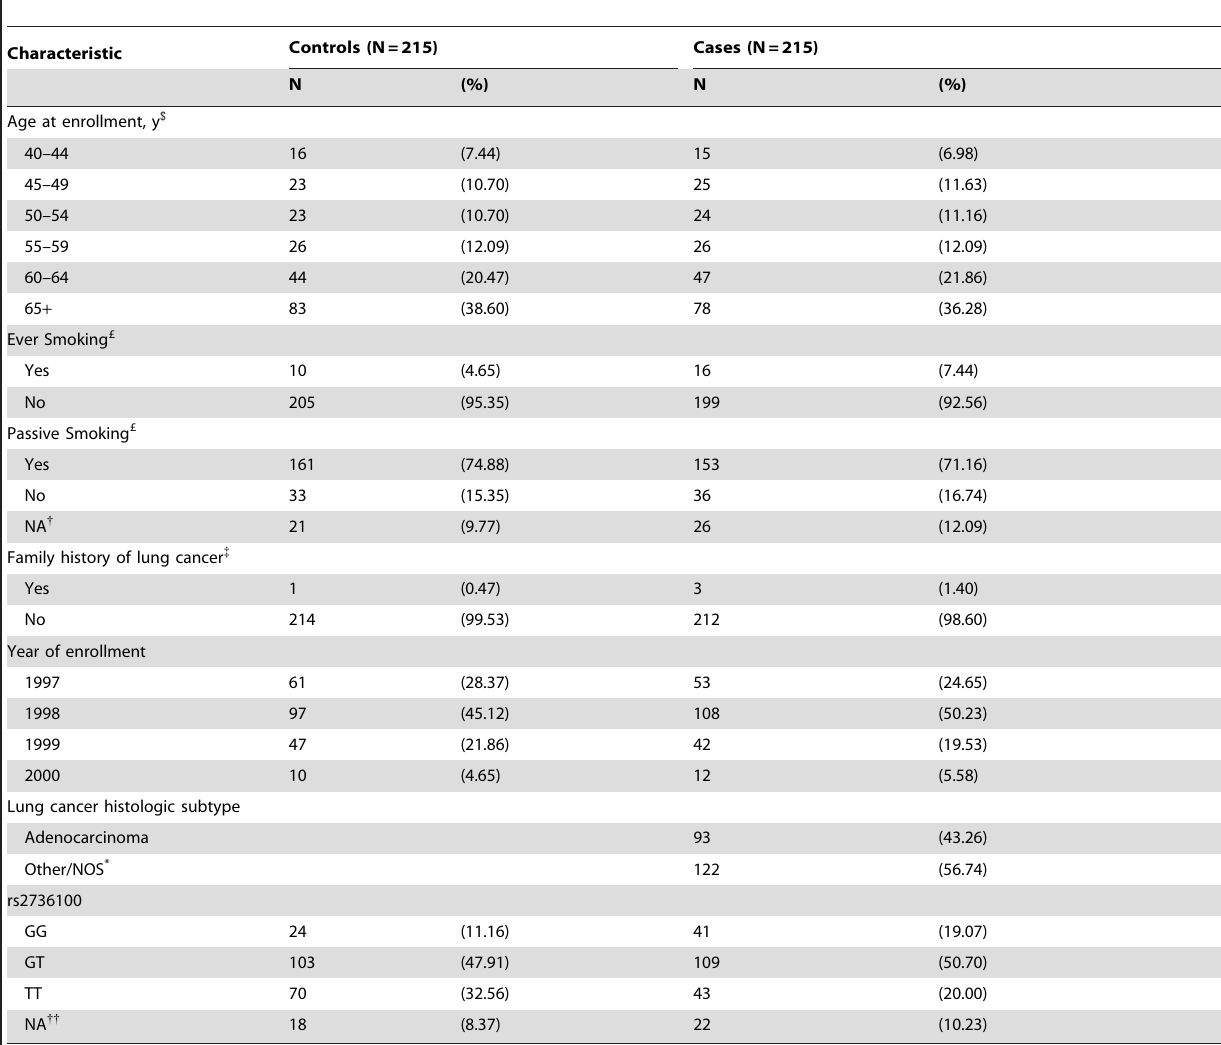
Table 1. Selected characteristic of lung cancer cases and individually matched controls selected from the Shanghai Women’s Health Study (recruited between